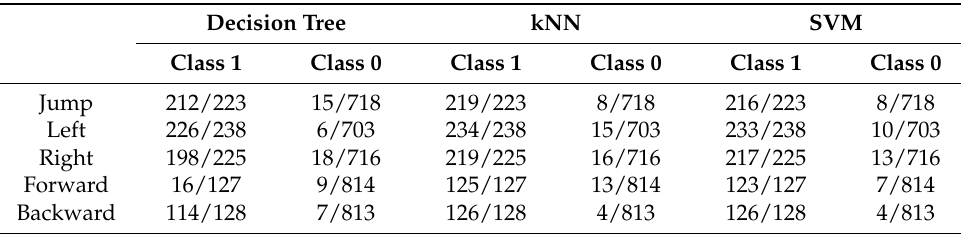
Table 3. Classification result of 25% held out validation.